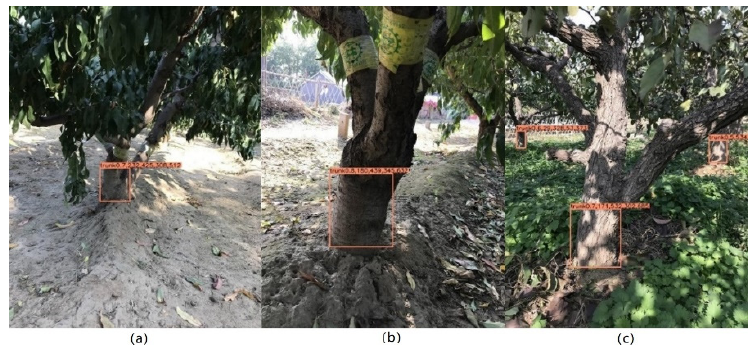
Figure 10. Detection results of trunk under weak sunlight.